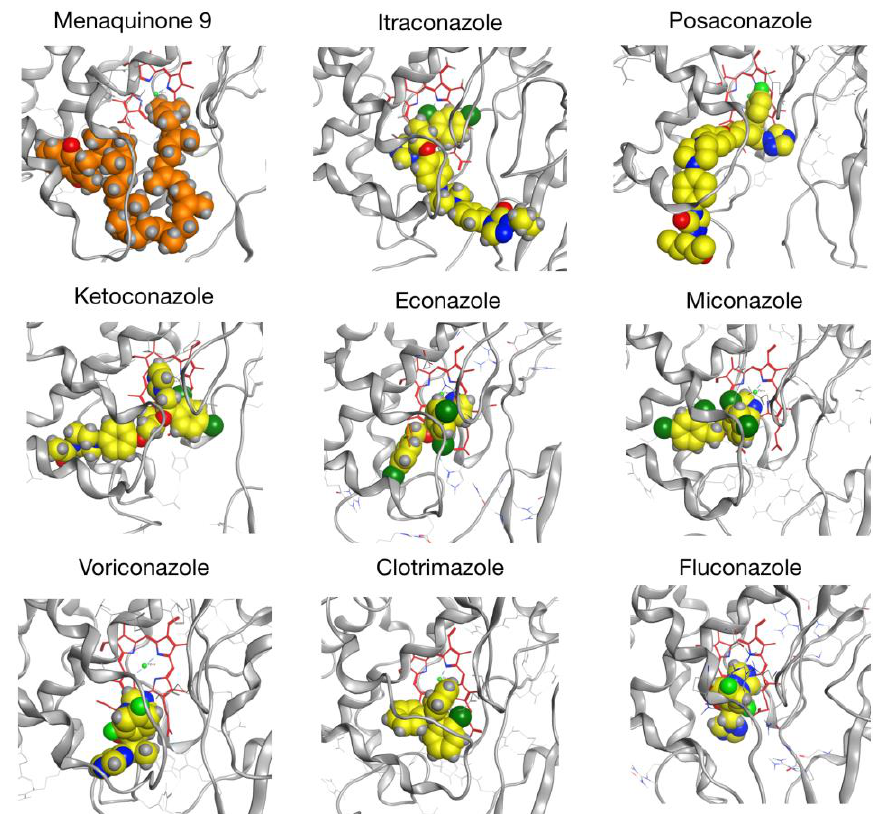
Figure 6. First well-oriented binding poses obtained for a substrate (menaquinone 9) and the azole compounds. The substrate/azole compounds are shown in orange/yellow, respectively, while the heme is shown in red and the ferric core is depicted in light green.